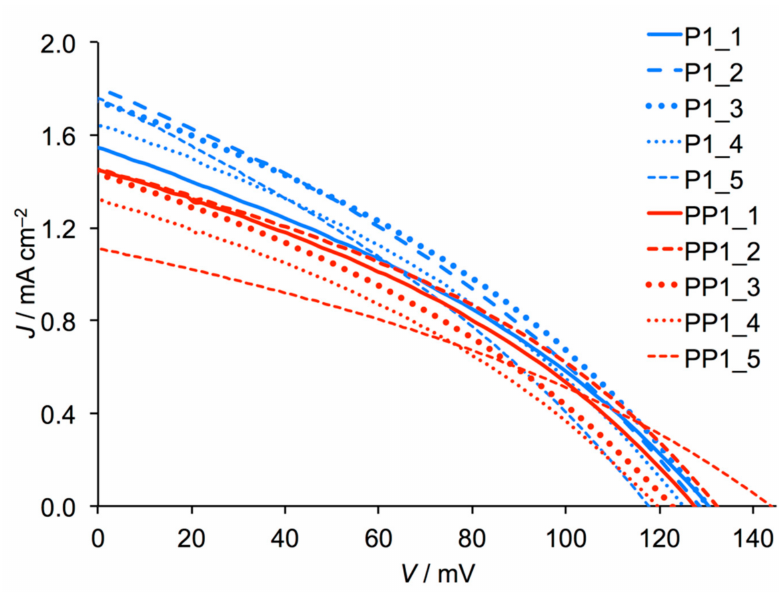
Figure 6. J–V curves for dye-sensitized solar cells (DSCs) containing dyes P1 and PP1 . Five replicate cells were made for each dye. Data are for the day that the cells were sealed and correspond to the values in Table 1. Table 1. DSC performance parameters for dyes P1 and PP1 on NiO in p-type DSCs. Data are for the day that the cells were sealed and five DSCs were made for each dye.